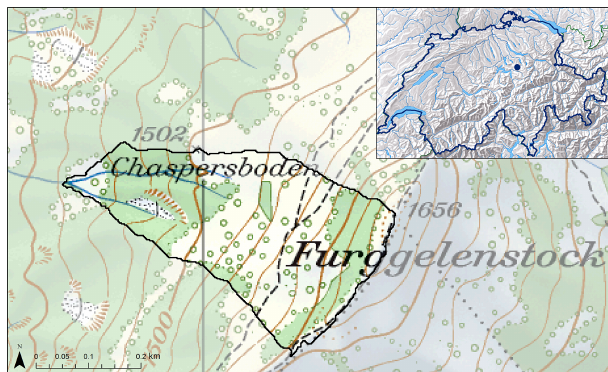
Figure 1. Map of the upper Studibach study catchment and its lo- cation in Switzerland (inset). Source: Federal Office of Topogra- phy (© Swisstopo) National Map 1:25000 (Pixelkarte 25) and Re- liefkarte